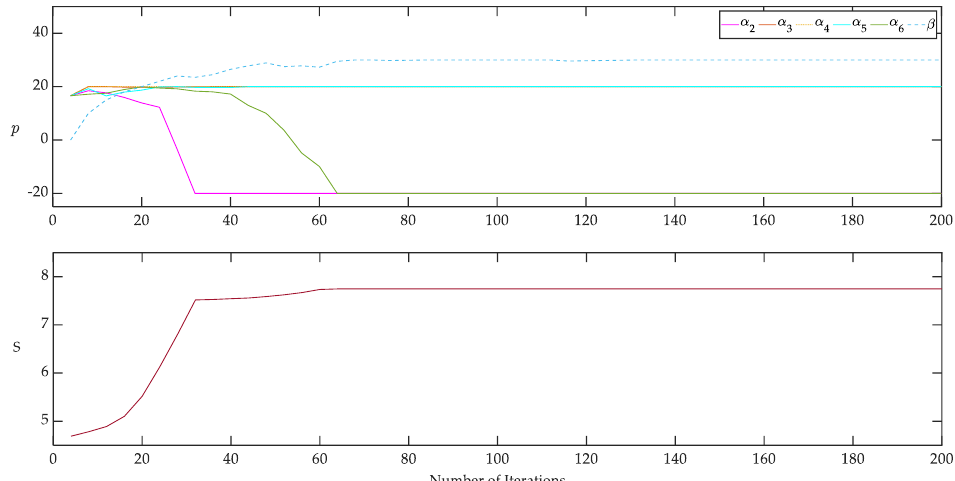
Figure 12. Optimization output: plot of actuator’s parameters and cost function trend against the number of iterations for actuator 1 failure and prescribed maneuver performance requirement.